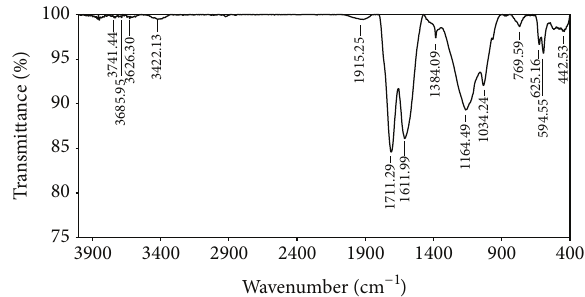
Figure 2: FTIR spectra of lead ion loaded CRSD.